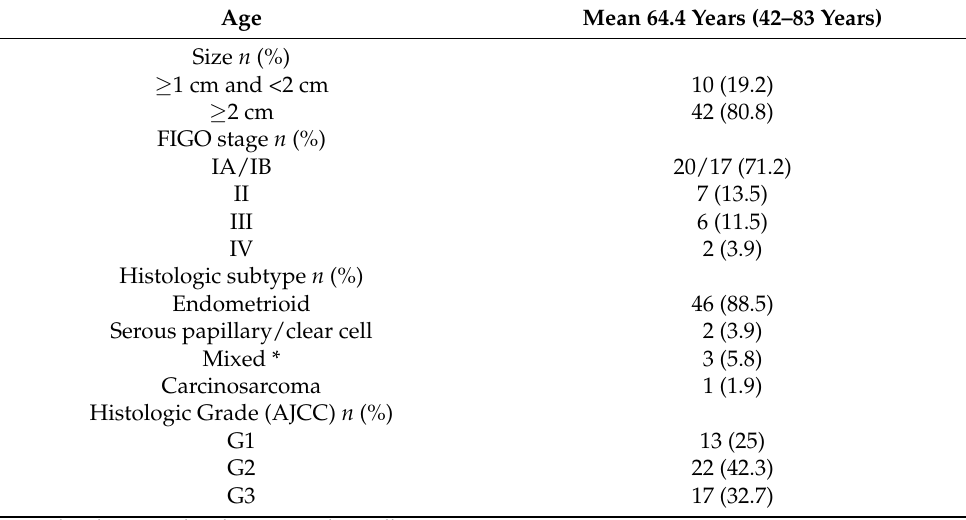
Table 1. Patient age and histologic findings.